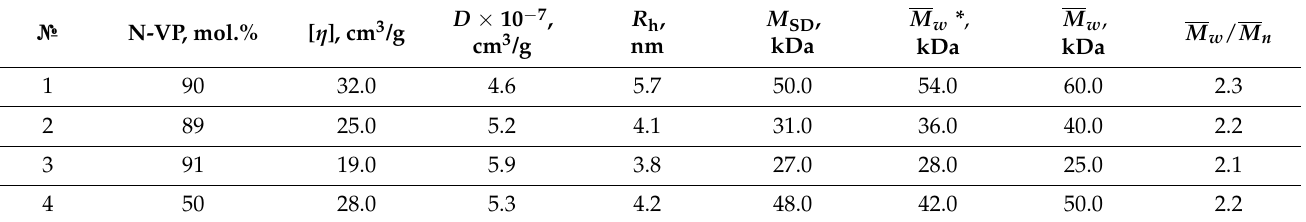
Hydrodynamic and molecular characteristics of copolymers [N-VP] n -[N-VA] m in 0.2 M